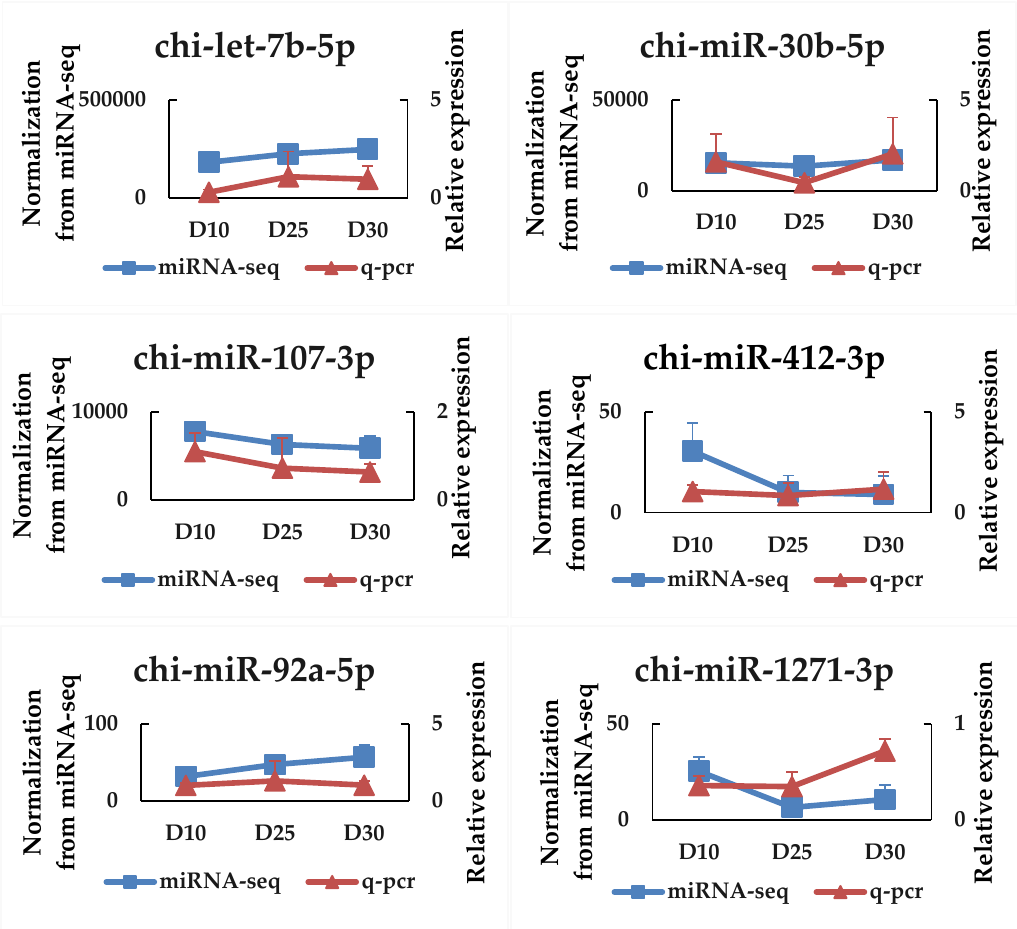
Figure 3. Validation of six selected DEmiRNAs by qPCR.